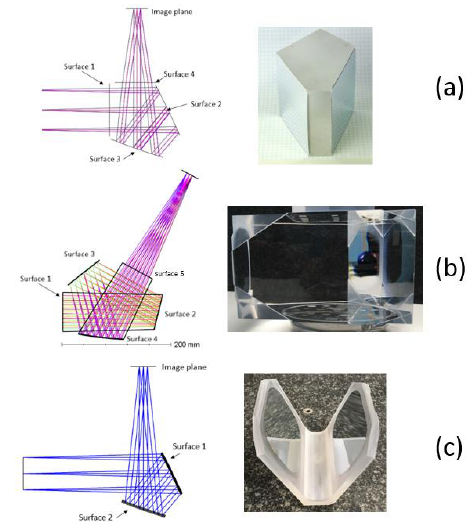
Figure 1. The three embodiments of monolithic telescopes shown with optical ray trace (left) and photograph of finished part (right). (a) Two freeform surface, solid prism, (b) diffraction limited, solid prism, and (c) two freeform, light- weight